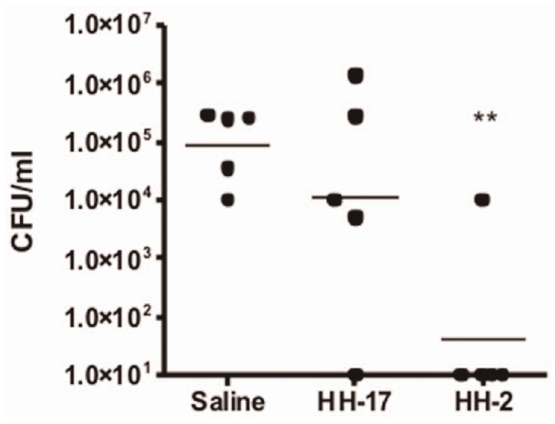
Figure 1. Protection by peptide HH2 against an invasive Staphylococcusaureus infection in mice, compared to a negative control peptide HH17. Mice were pretreated with saline (control) or 4 mg/kg peptide (IP) in saline, and infected 4 hours later with approximately 1.0 6 10 9 CFU of S. aureus . Twenty-four hours post infection, mice were euthanized and the peritoneal lavage taken, and plated on Mueller Hinton agar. The graph is representative data from a series of 2 independent experiments. *represents p ,